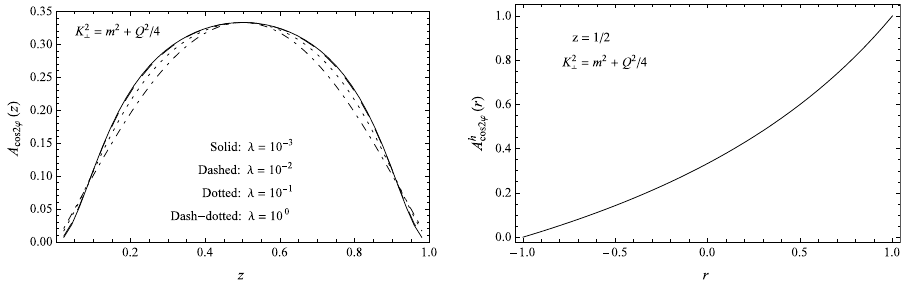
(cid:12) (cid:12) (cid:12) (cid:12) (cid:12) (cid:126) K ⊥ (cid:12) at several values of Q 2